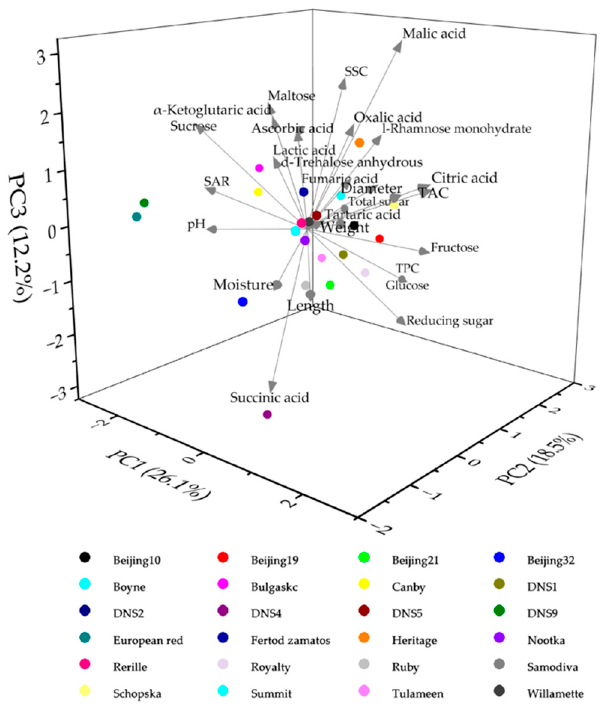
Figure 5. Three-dimensional principal component analysis (PCA) plot of the quantitative traits and 24 red raspberry varieties.